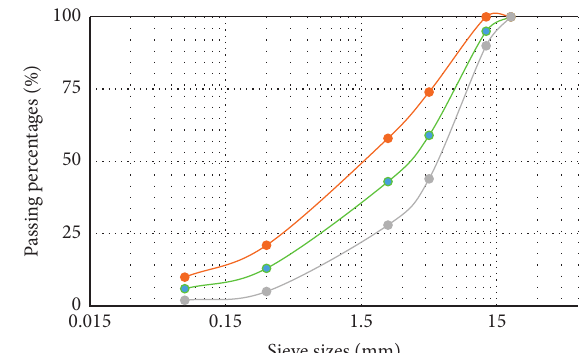
Figure 1: The process of the research method.